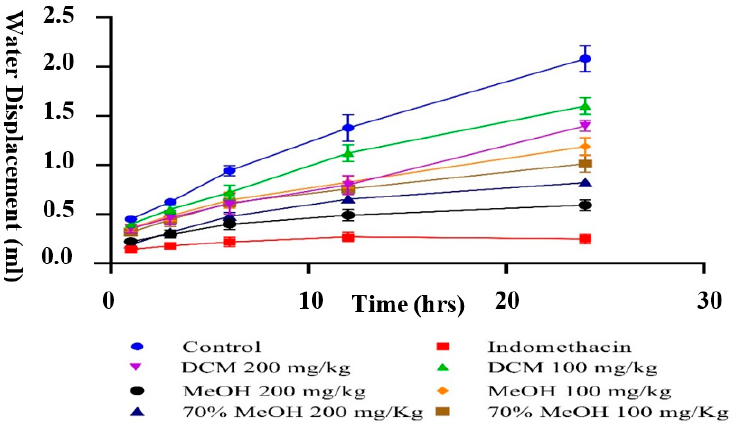
Figure 4. Inhibition against formaldehyde-induced paw edema by Peganum harmala sequential crude extracts. Values are mean ± SEM. p < 0.05 was considered significant (* p < 0.05, ** p < 0.01, *** p < 0.001, **** p < 0.0001).